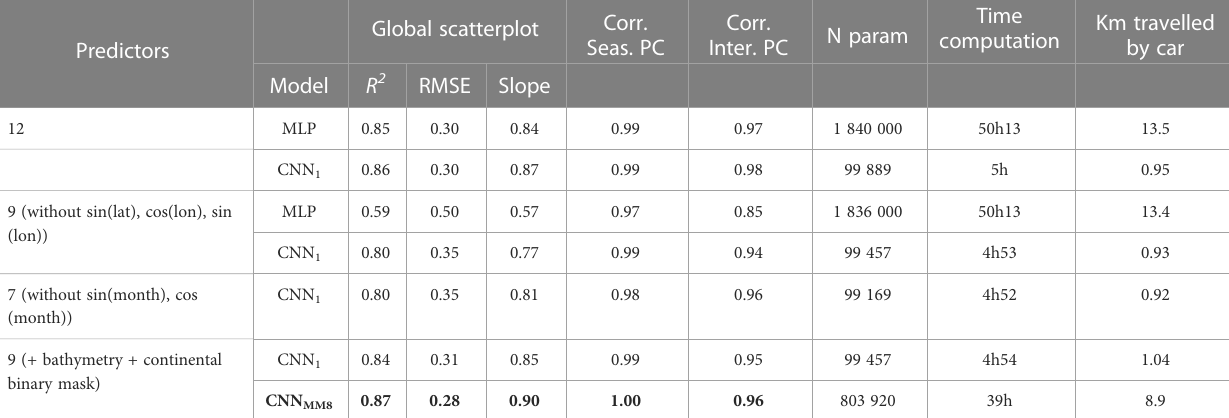
Corr. Global scatterplot Corr. Seas. PC Inter.